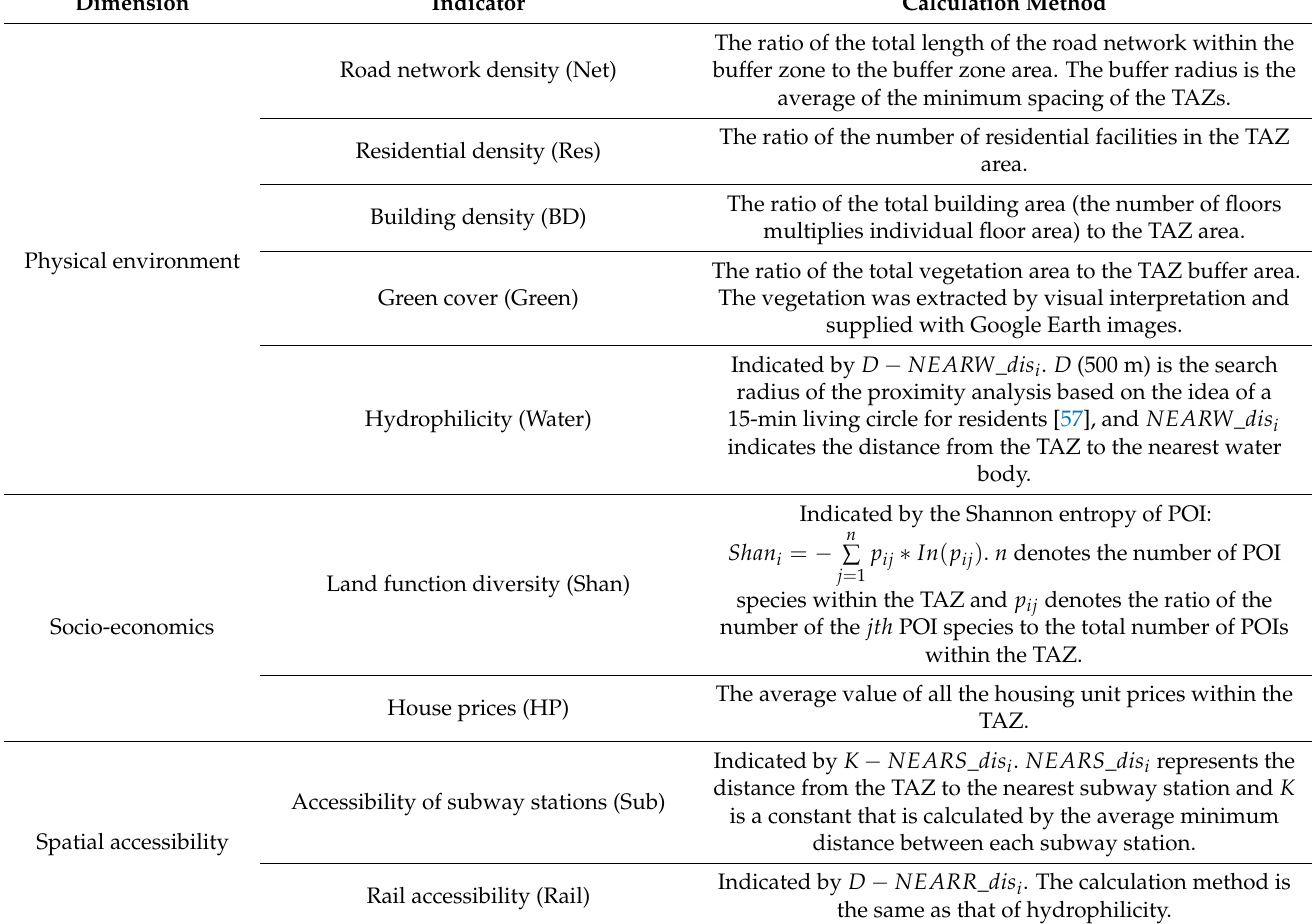
Table 2. Calculation methods of influencing